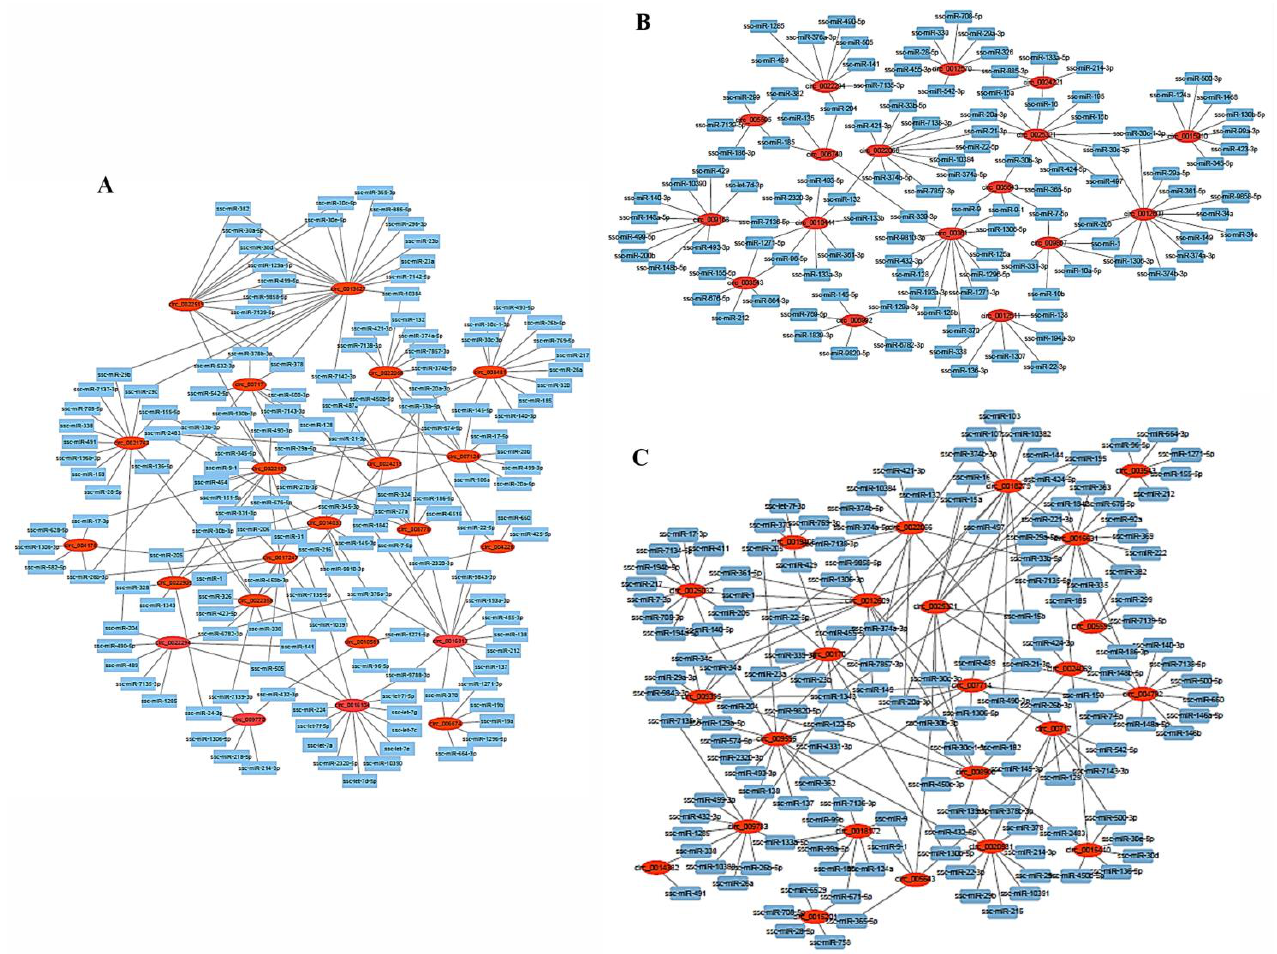
Figure 3. CeRNA network of DEcircRNAs. ( A ): 1 day of age; ( B ): 90 days of age; and ( C ): 180 days of age.